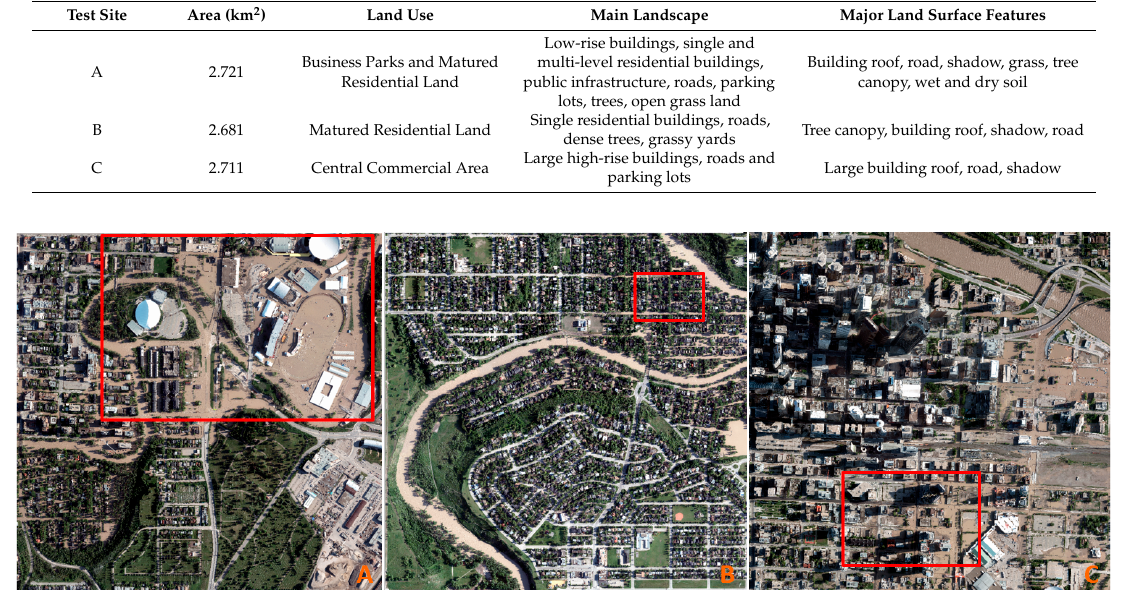
Figure 1. The location of the study area and the coverage of the image dataset over the center of Calgary, Canada. The image on the right is from aerial photos on 22 June 2013, with the coverage (in orange-colored frames) of the test sites. Table 1. Description of the test sites.